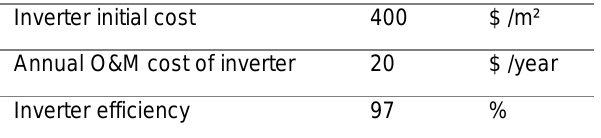
Table 6 . Inverter parameters